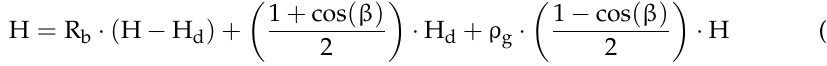
Figure 3. The examined cities and the Greek climate zones, Reprinted with permission from ref.